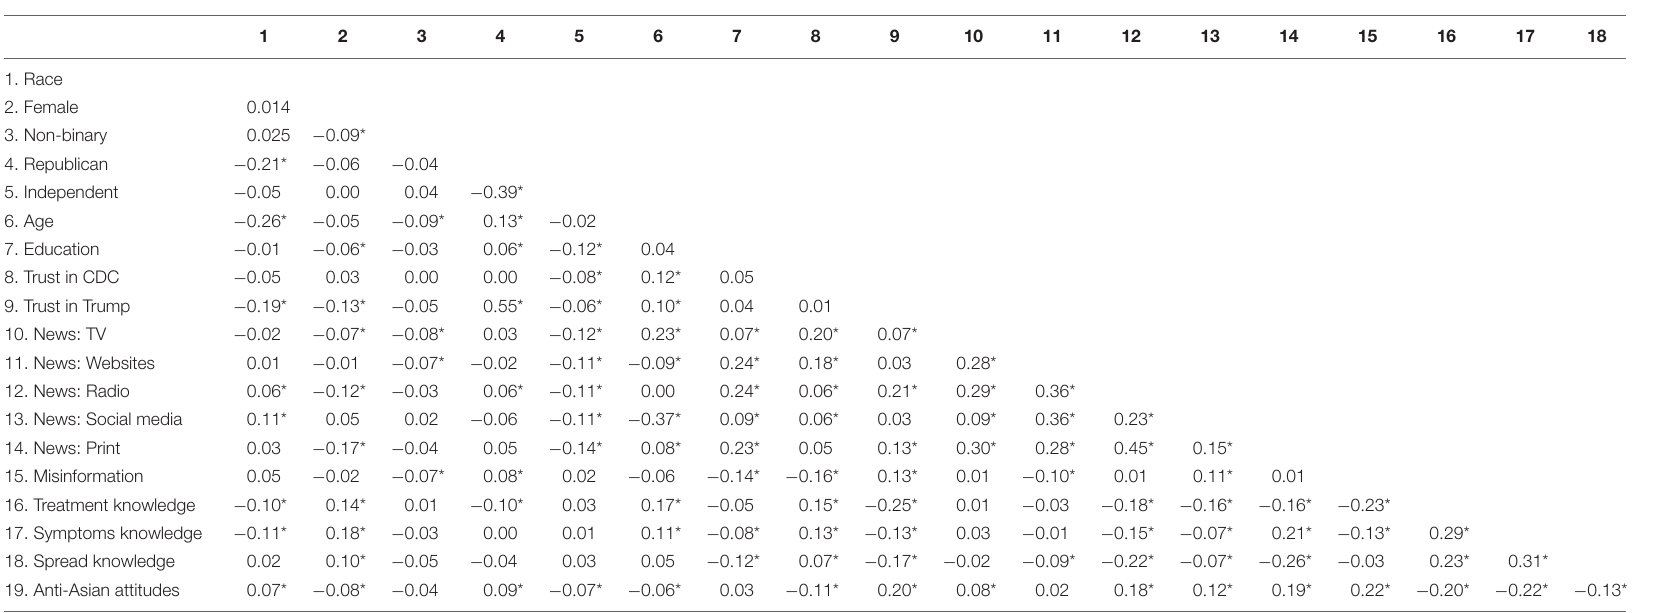
TABLE 1 | Intercorrelations among study